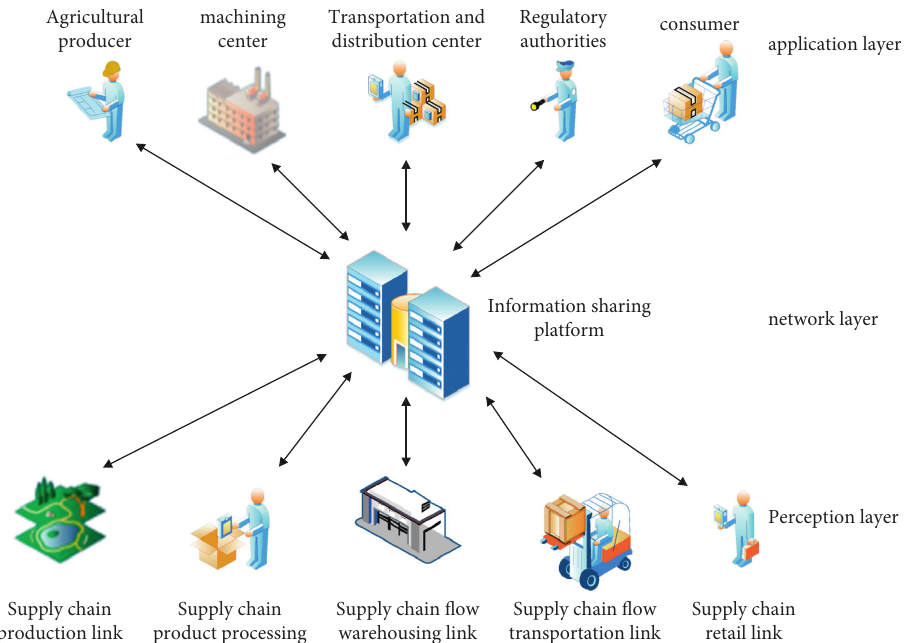
Figure 1: Block diagram of rural economic supply chain system based on Internet of Things